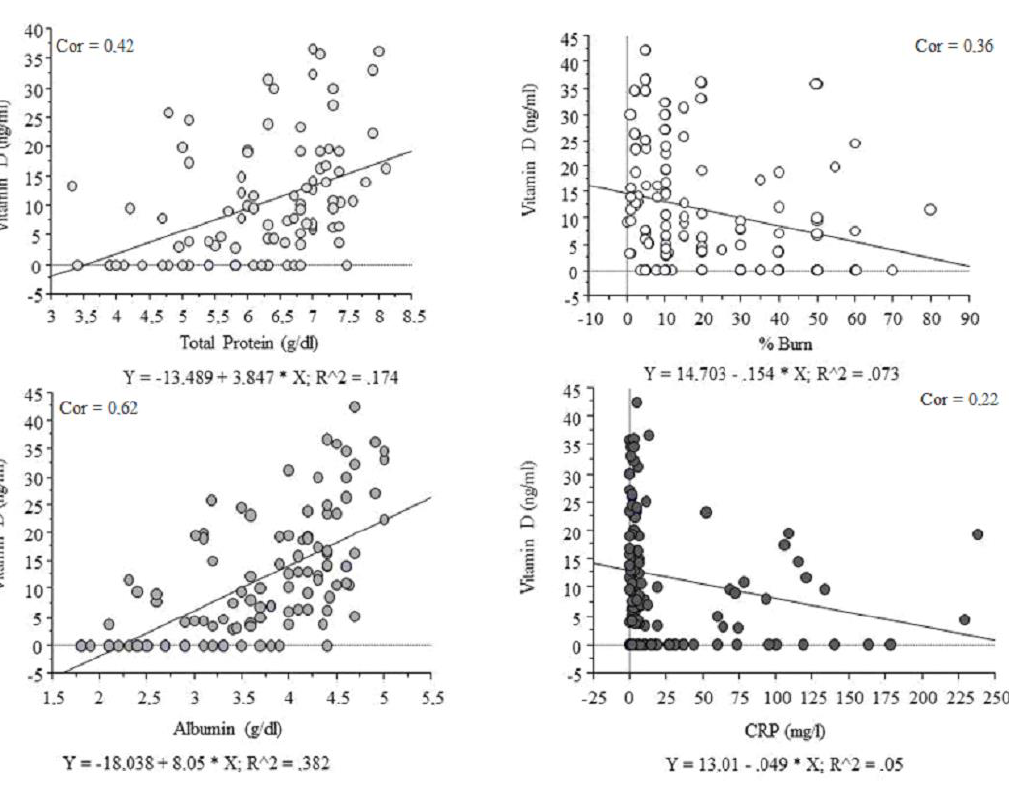
Figure 1. 25-hydroxycholecalciferol concentration and biochemical status; CRP: c-reactive